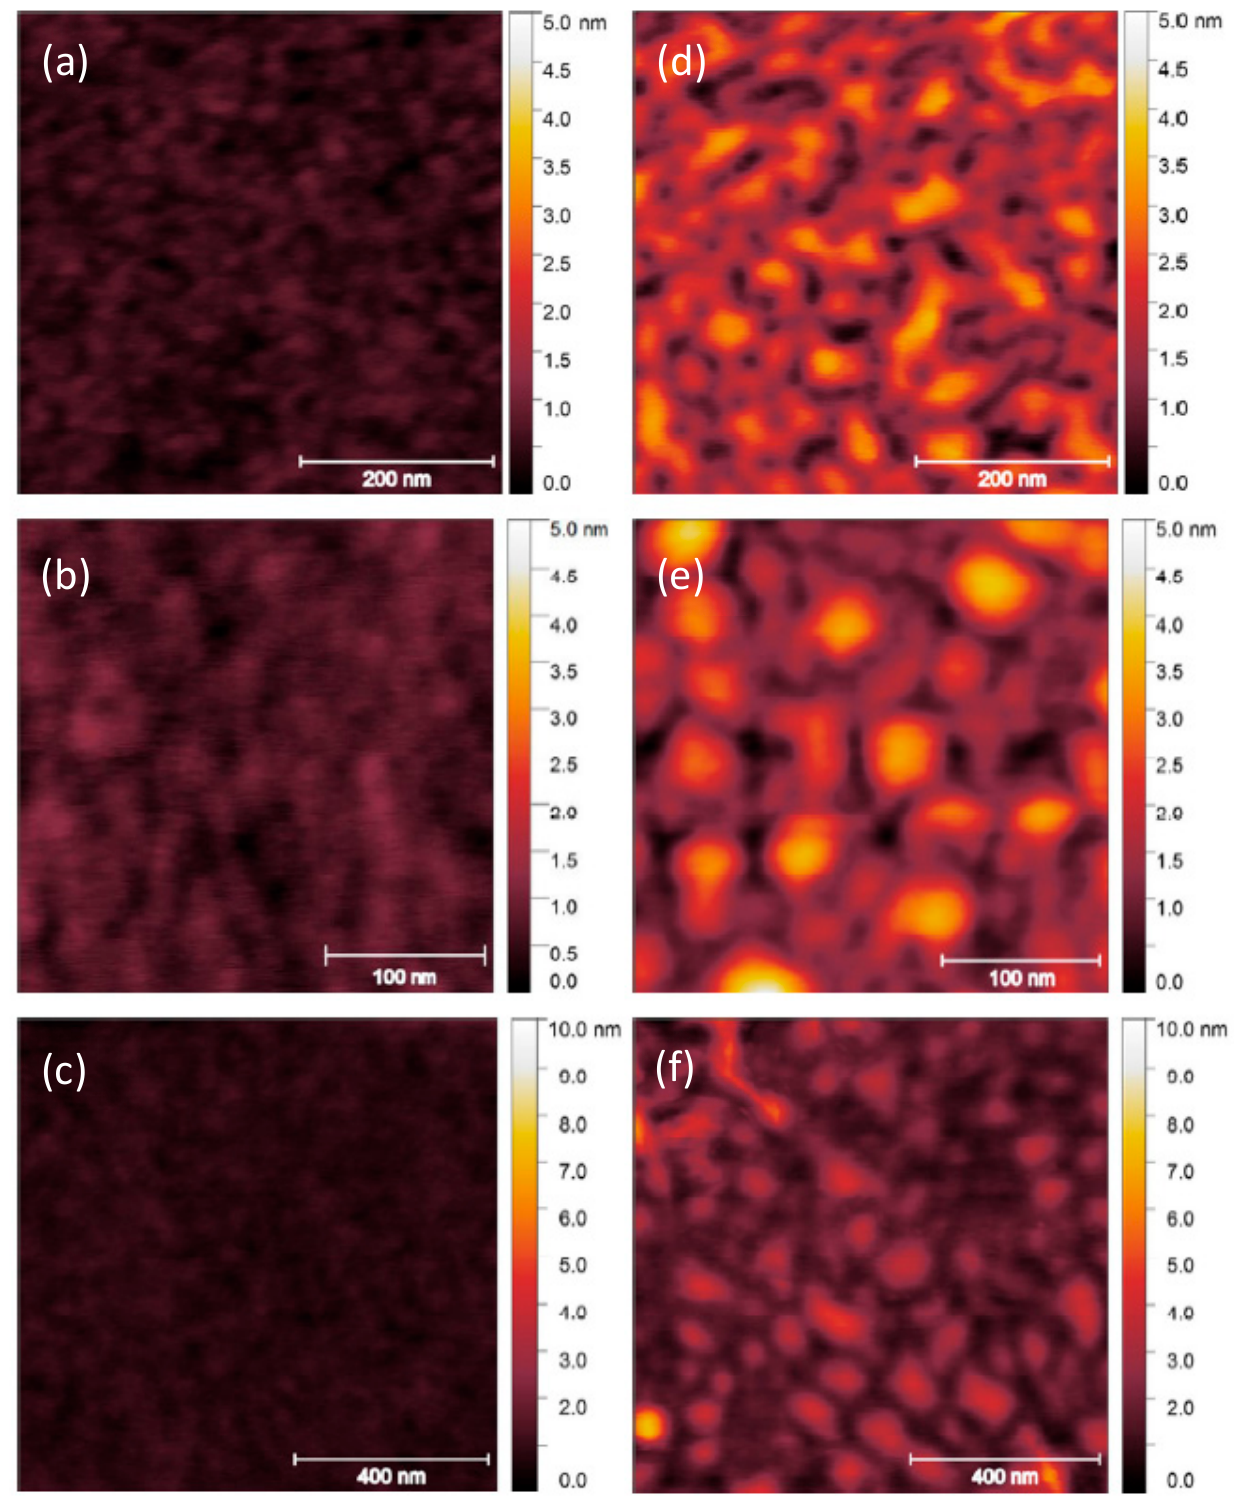
Figure 7. AFM images of the CS200 ( d ), CS330 ( e ), and CSMT ( f ) samples on Si wafers, with the corresponding images of clean Si wafers on the left ( a – c ).